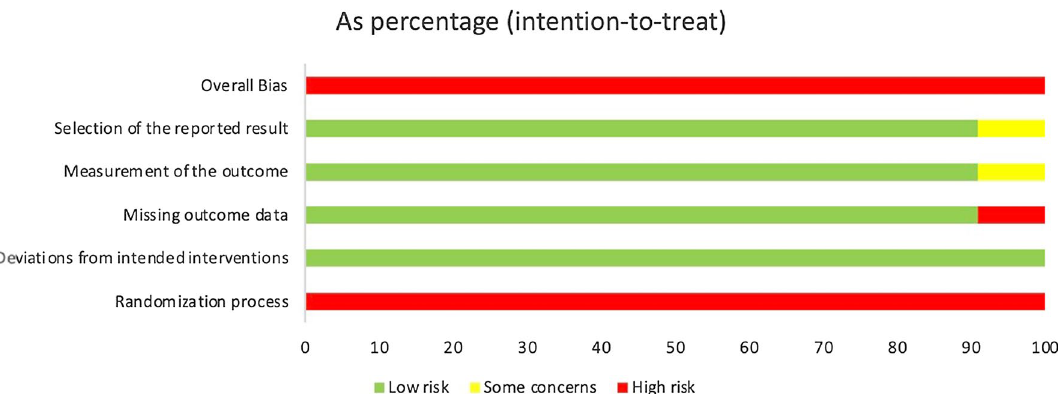
Fig. 2 Quality assessment of controlled clinical